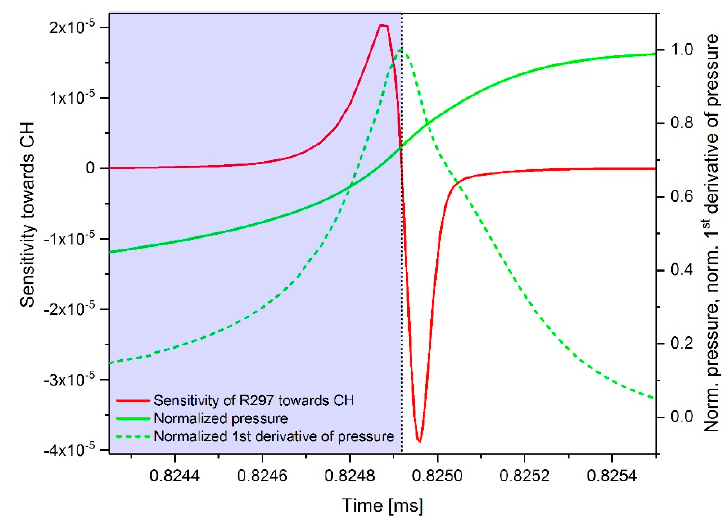
Figure 14. Simulated time-dependent sensitivity sequence of the reaction 297 ( n -C 7 H 15 + O 2 ↔ n -C 7 -QOOH) towards CH in the area of ignition for an n -heptane–air mixture at φ = 1, T = 750 K and p = 60 bar.